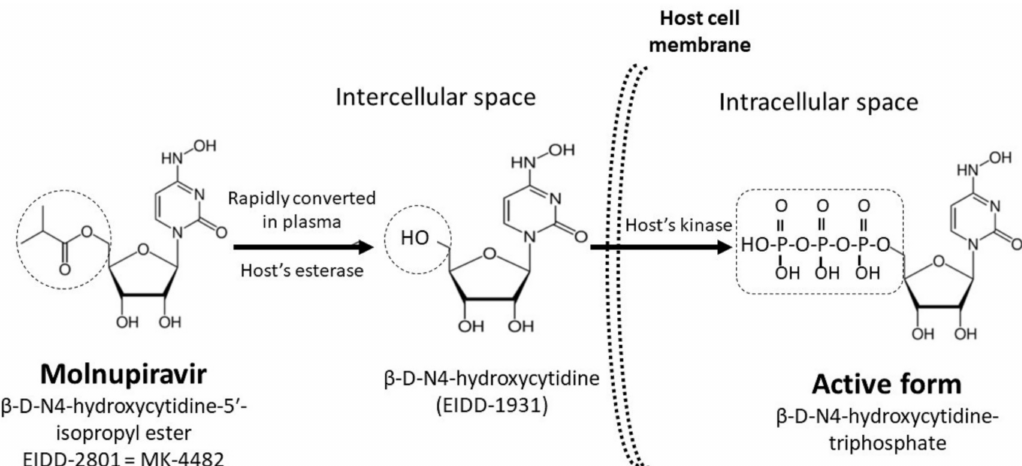
Figure 1. In plasma, molnupiravir is rapidly converted to EIDD-1931, which is converted into EIDD-1931-triphosphate, the active antiviral compound, after penetration into SARS-CoV-2-infected